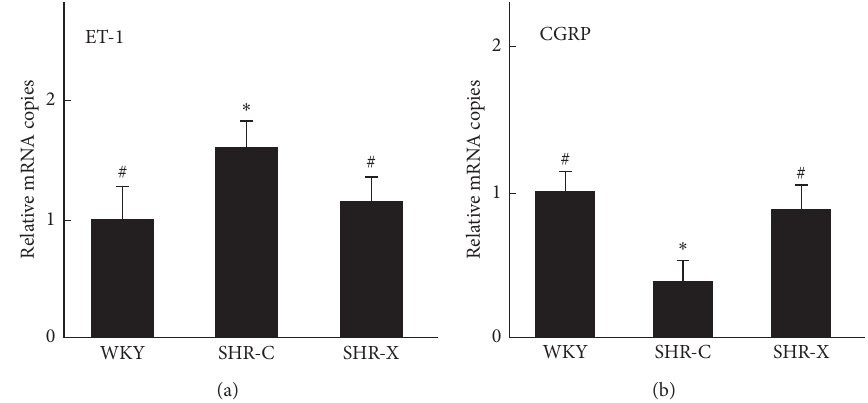
Figure 3: The level of ET-1 and CGRP mRNA. Values are means ± SD. WKY: Wistar-Kyoto rats; SHR: spontaneously hypertensive rats; SHR-C: SHR control; SHR-X: SHR Xinmaitong treatment; ET-1: endothelin-1; CGRP: calcitonin gene-related peptide. ∗ P < 0 . 05 versus WKY. # P < 0 . 05 versus SHR-C.